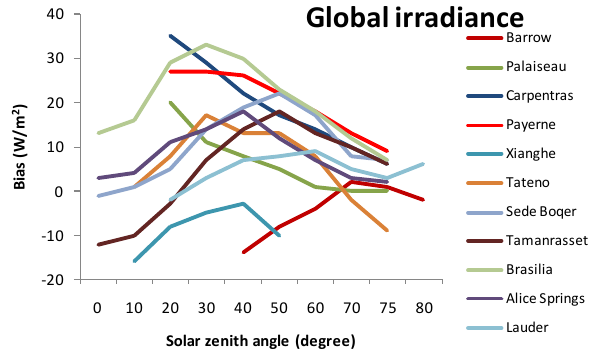
Fig. 12. Change in bias as a function of the solar zenith angle for all stations. Global irradiance.